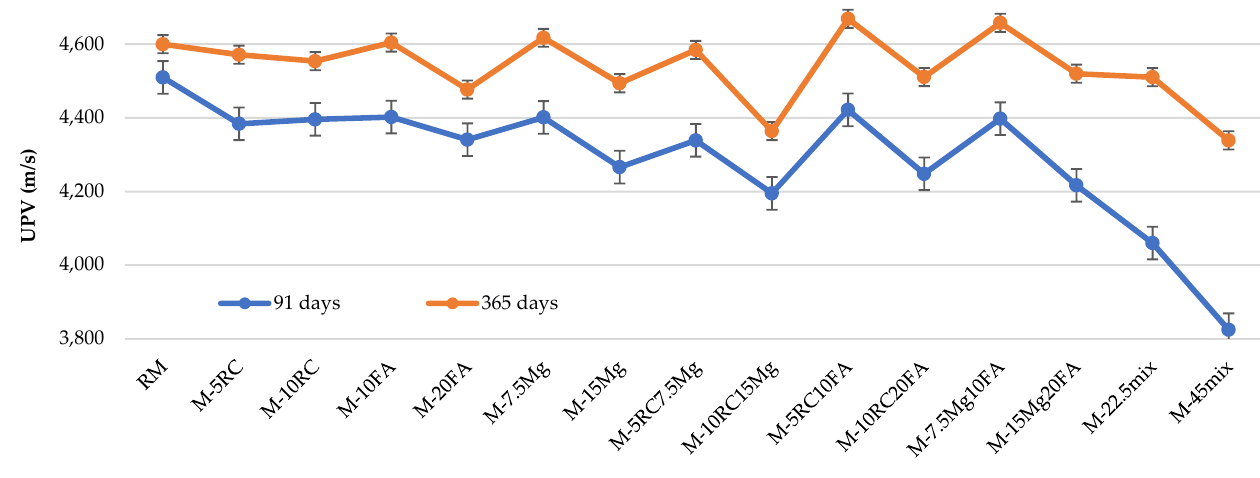
Figure 7. Ultrasonic pulse velocity at 91 and 365 days.